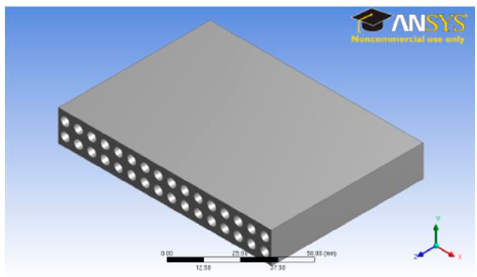
Figure 10. Flow restrictor [14].